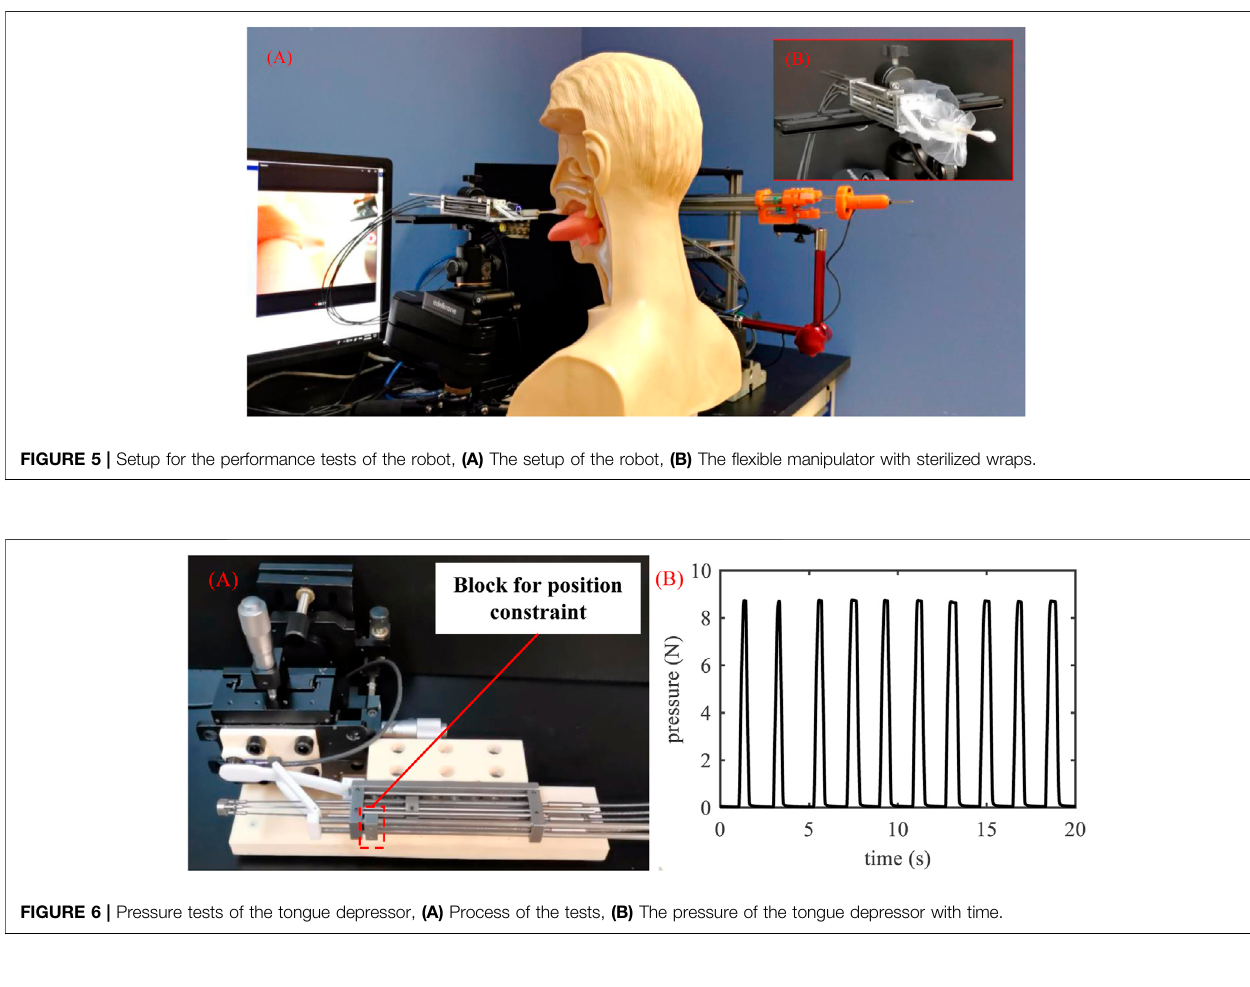
Frontiers in Robotics and AI |